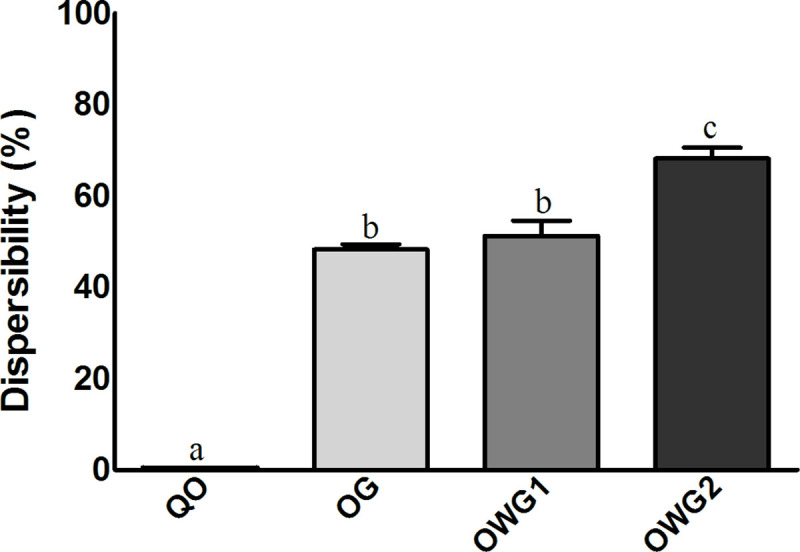
Dispersibility percentages for crude Quinoa Oil (QO) and powder particles obtained by O/W emulsification technique.(A) OG: Quinoa oil and porcine gelatin in aqueous phase 2; (B) OWG1: Quinoa oil, whey protein isolate and porcine gelatin in aqueous phase 2; (C) OWG2: Quinoa oil, whey protein isolate in aqueous phase 1, and porcine gelatin in aqueous phase 2. The values were compared to each other by means of variance analysis with Tukey post-hoc (p < 0.05). *Mean and standard deviation (SD), n = 3. *Equal letters mean that there was no significant difference, according to Tukey post-hoc (p>0.05).